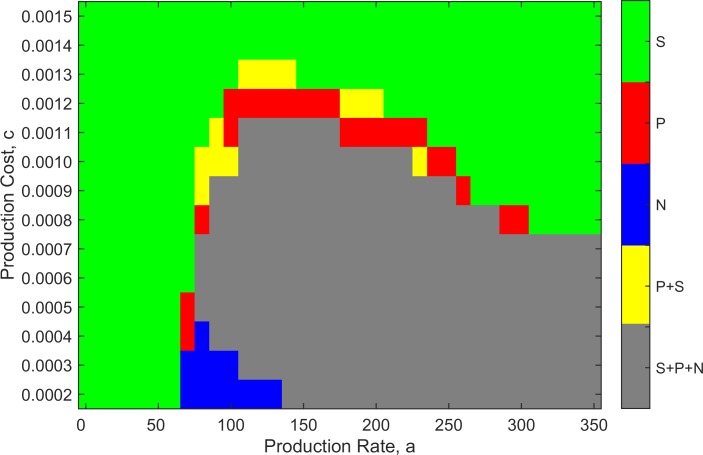
Majority outcomes of 100 runs of time 10,000 as a function of production rate a and production cost c.Green–S only; red–P only; blue–N only; grey–S, P and N; yellow–S and P. Parameters: r1 = 2, r2 = 2.5, v = 1, b = 10, L = 1024x1024, δt = 0.01.